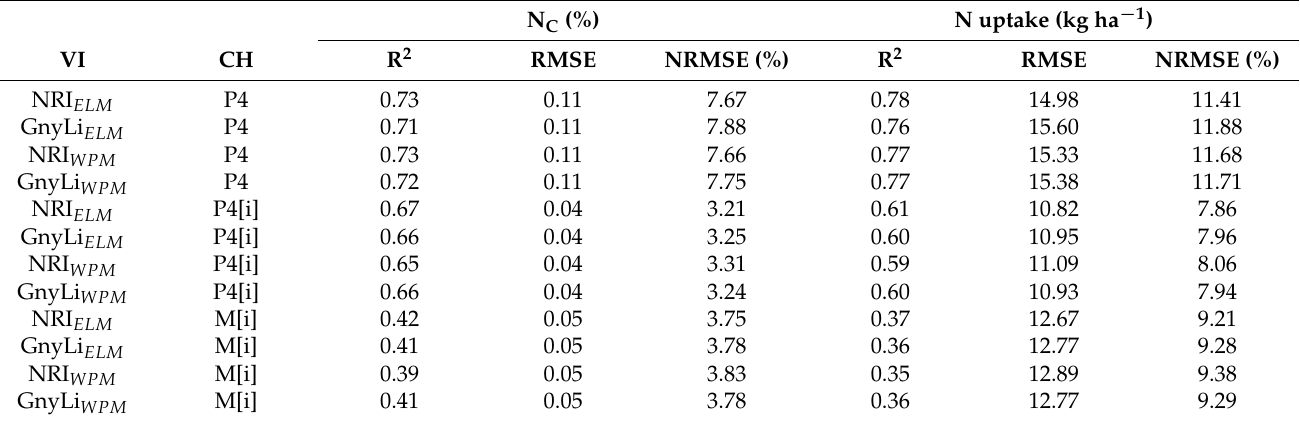
Table 5. Results of the simple linear regression analyses for both calibration methods (ELM, WPM) of both VIs (NRI, GnyLi) and the estimated (by three different CH) crop traits: N C and N uptake. Three crop heights: P4: P4RTK crop height, M: manual crop height, [i]: interpolated crop height values. ( p < 0.001 for all regression models).